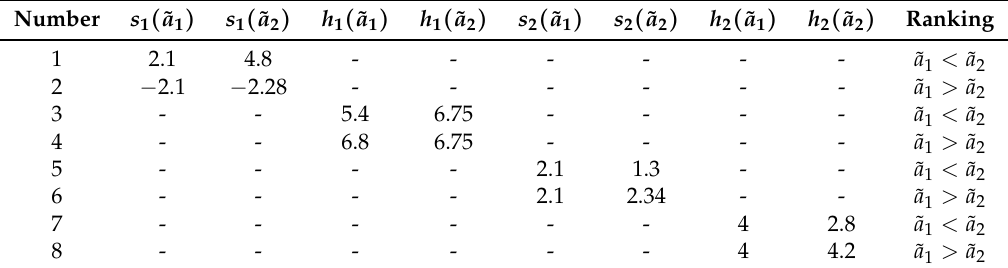
Table 2. The score function and accuracy function of the numerical